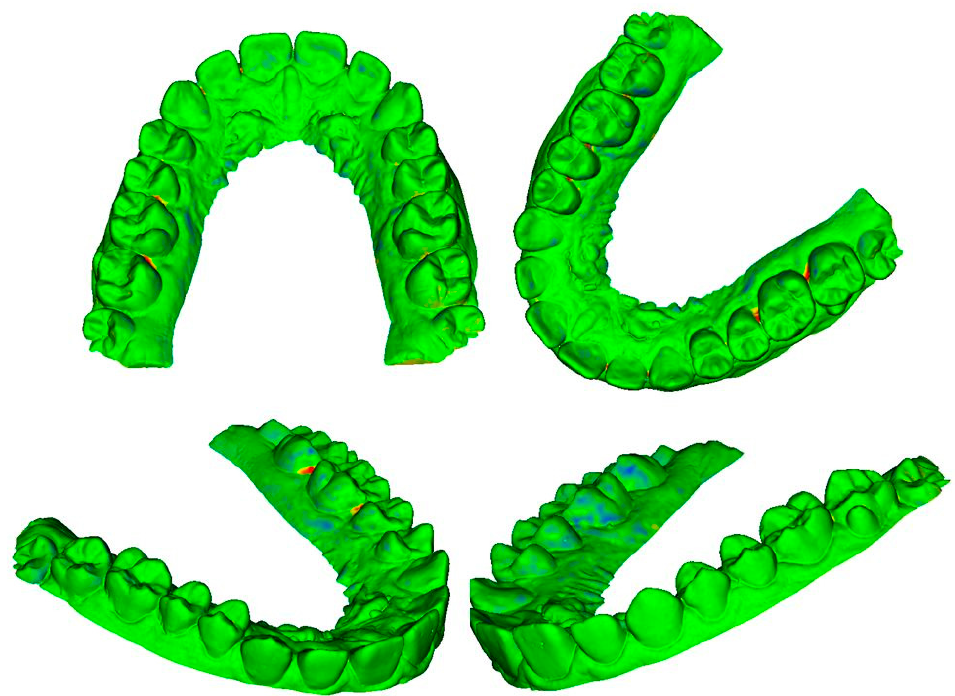
Figure 7. Color bar used to visualize discrepancies between digital dental models.